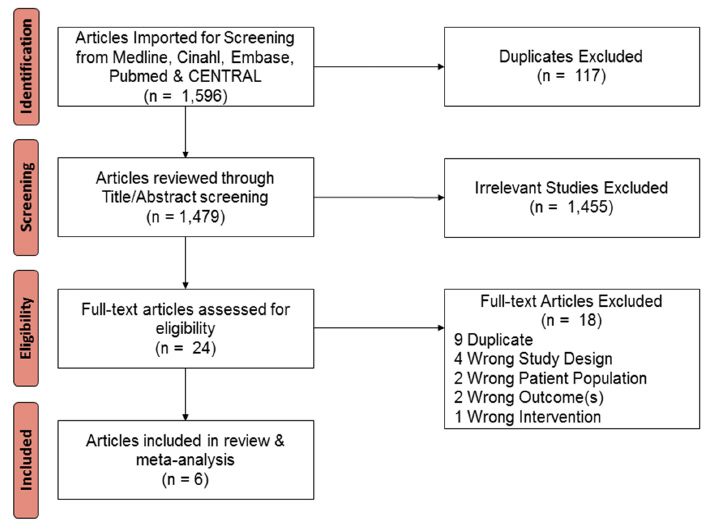
Figure 1. Flow diagram of study selection using Preferred Reporting Items for Systematic Reviews and Meta-Analyses (PRISMA) guidelines.